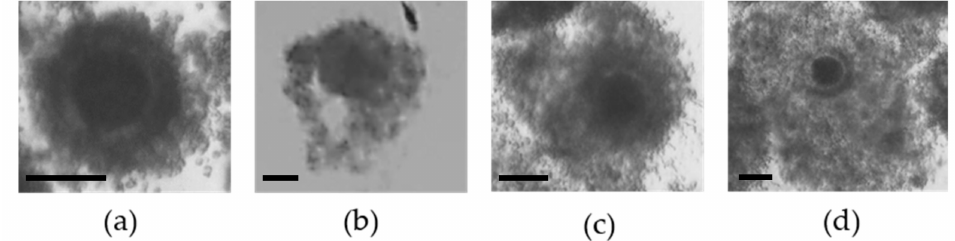
Figure 6. Grades of cumulus cell expansion in cumulus-oocyte complexes (COCs) after 24 h incubation in maturation media. ( a ) unexpanded COC (score 0), ( b ) poorly expanded COC (score 1), ( c ) partially expanded COC (score 2) and ( d ) and full y expanded COC (score 3). Scale bar = 100 µ